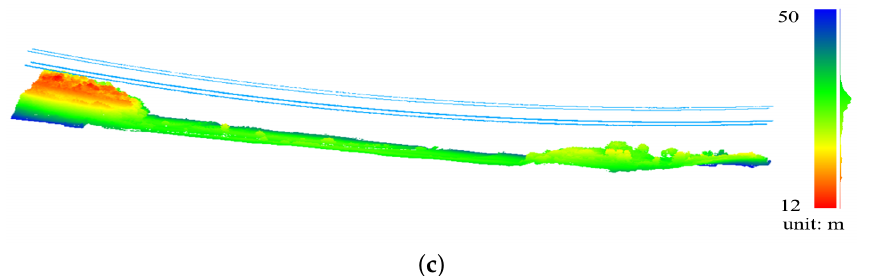
Figure 19. The safetydistance calculation results of the corridor in three different voltage levels of power lines. The ground points are colored according to the distance from the power lines. The colormap on the right represents the actual distance corresponding to different colors. ( a ) The safety distance result of 220 kV power line corridor. ( b ) The safety distance result of 500 kV power line corridor. ( c ) The safety distance result of 750 kV power line corridor.